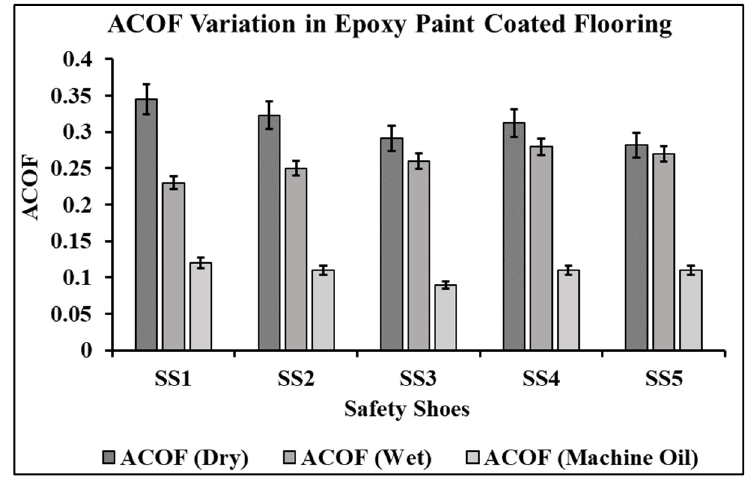
Figure 6. ACOF variation in epoxy-coated flooring across dry, wet, and machine oil slip setting.